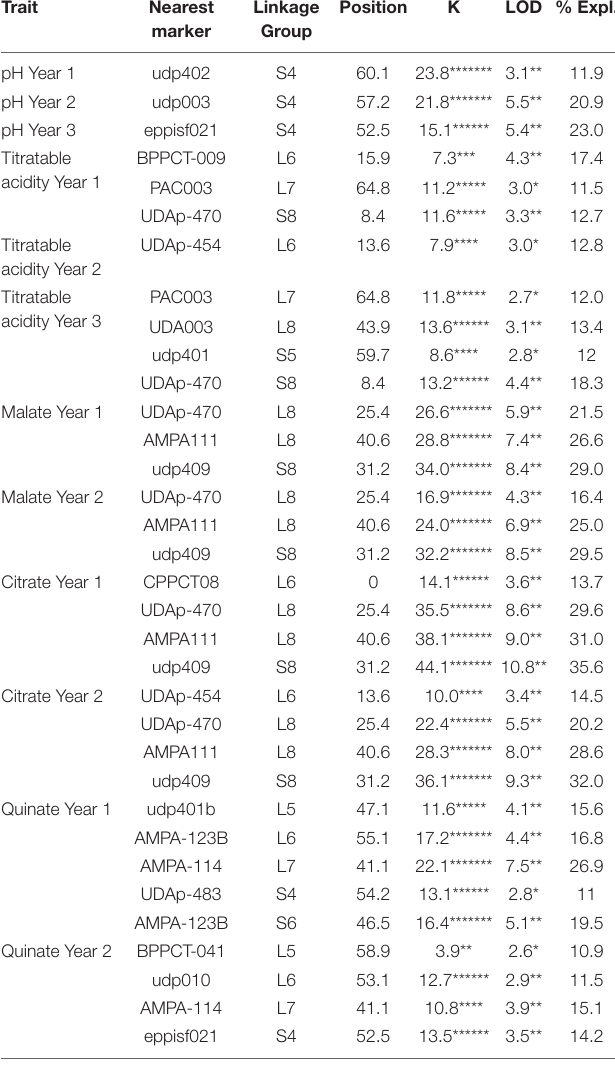
TABLE 3 | Summary of the most significant markers linked to quantitative trait loci (QTLs) of fruit acidity traits by interval mapping (IM) and the Kruskal–Wallis (K) test and percentage of the variance explained for by the QTLs in a F1 apricot progeny of ‘Lito’ × ‘BO81604311’ during the 3 years of analysis.